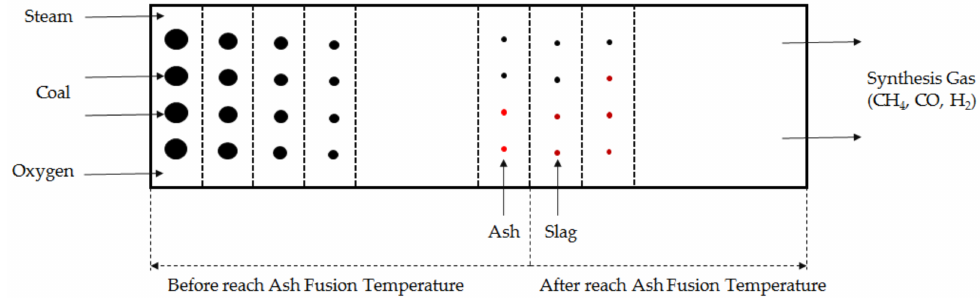
Figure 1. Gasifier internal scheme that considers melting of ash. Red dot: ash; brown dot: slag.